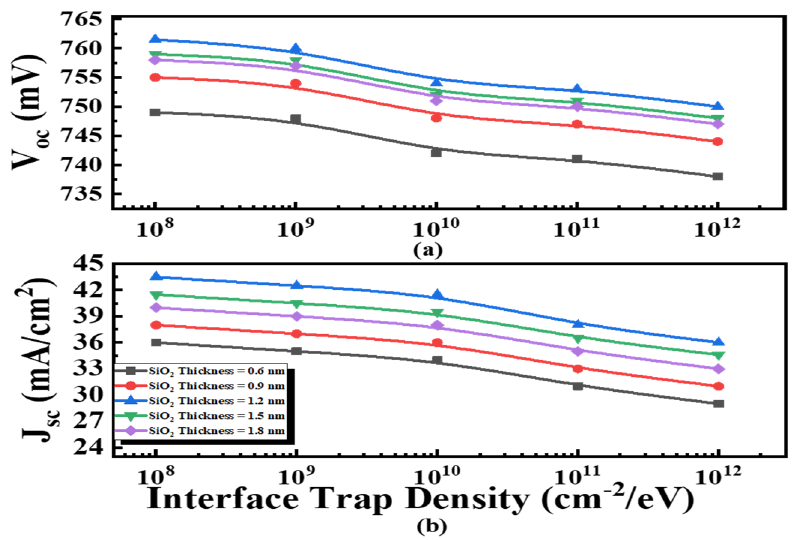
Figure 9. Effect of various interface trap densities (1 × 10 8 –1 × 10 12 cm − 2 /eV) with various oxide thick- nesses (0.6–1.8 nm) on ( a ) V oc and ( b ) J sc on the TOPCon solar